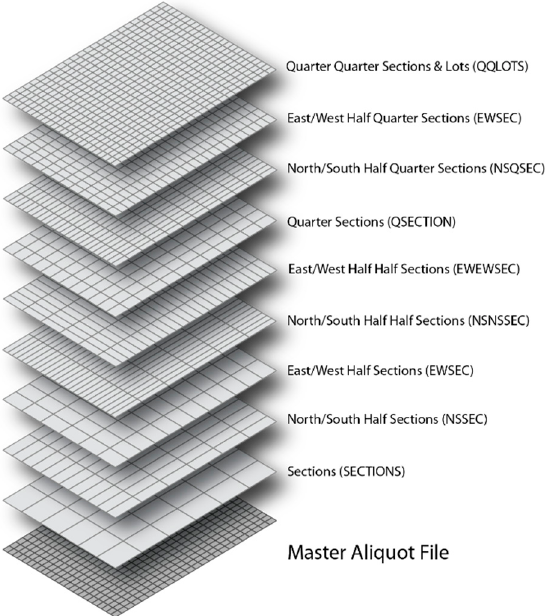
Figure 3. The “master aliquot” is a GIS data layer that contains the shapes of all possible aliquot parcels within a section merged together into one comprehensive file. Each parcel contains a Unique ID which is used by the allotment mapping tool to join the allotment spreadsheet and create the allotment parcel shapes with accompanying attribute data.